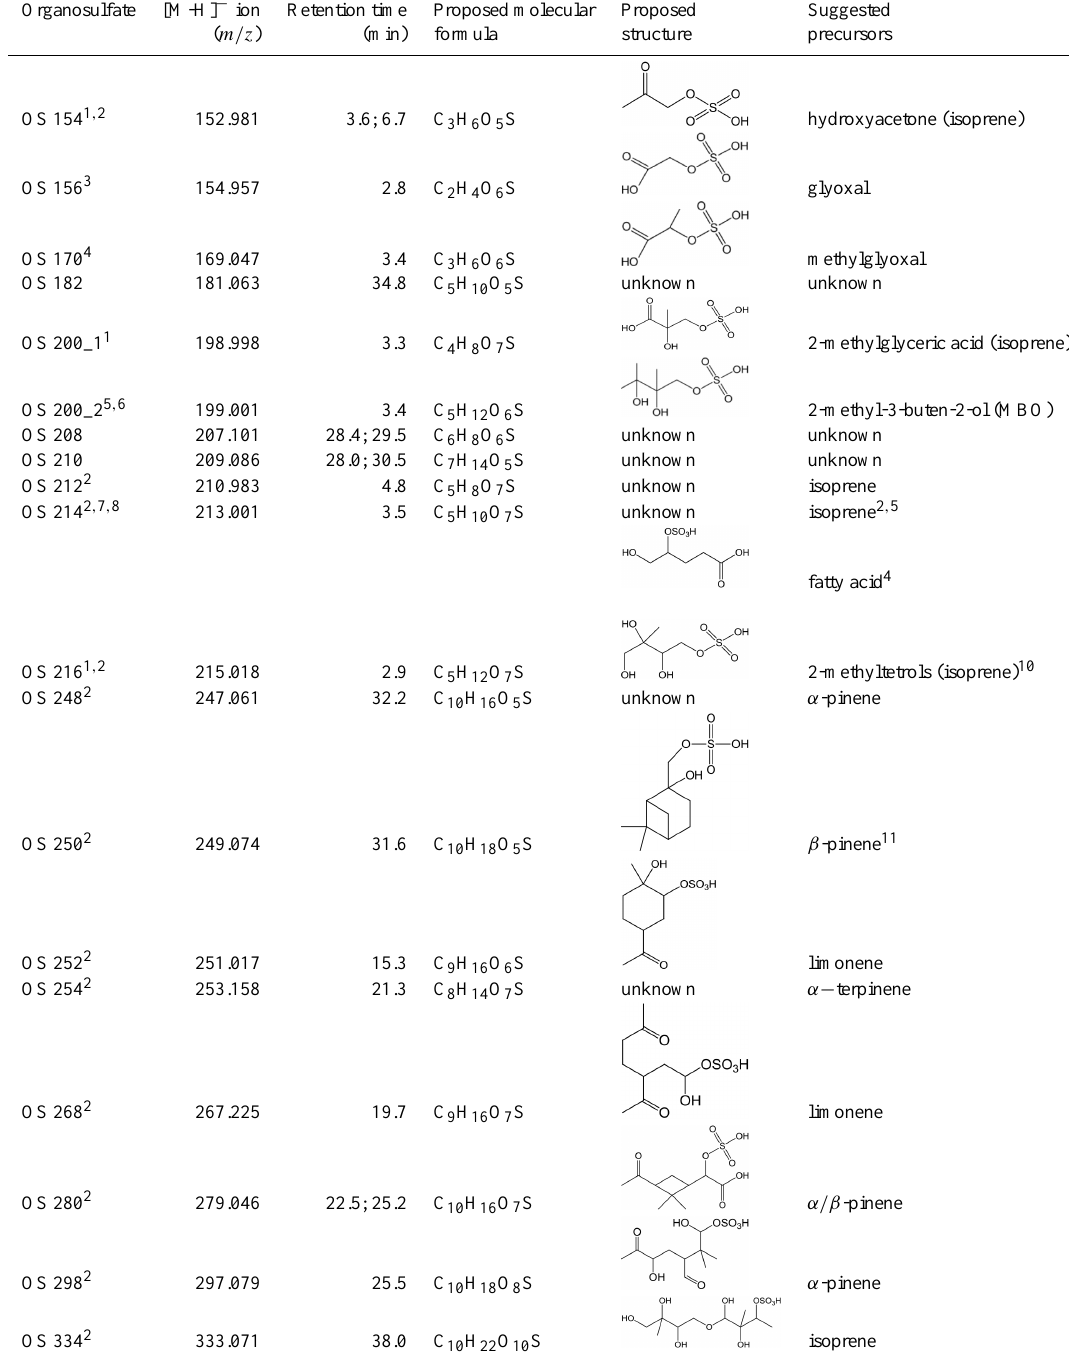
Table 2. Detected organosulfates (OS) during the campaign. Organosulfate [M-H] − ion Retention time Proposed molecular Proposed Suggested ( m/z ) formula structure